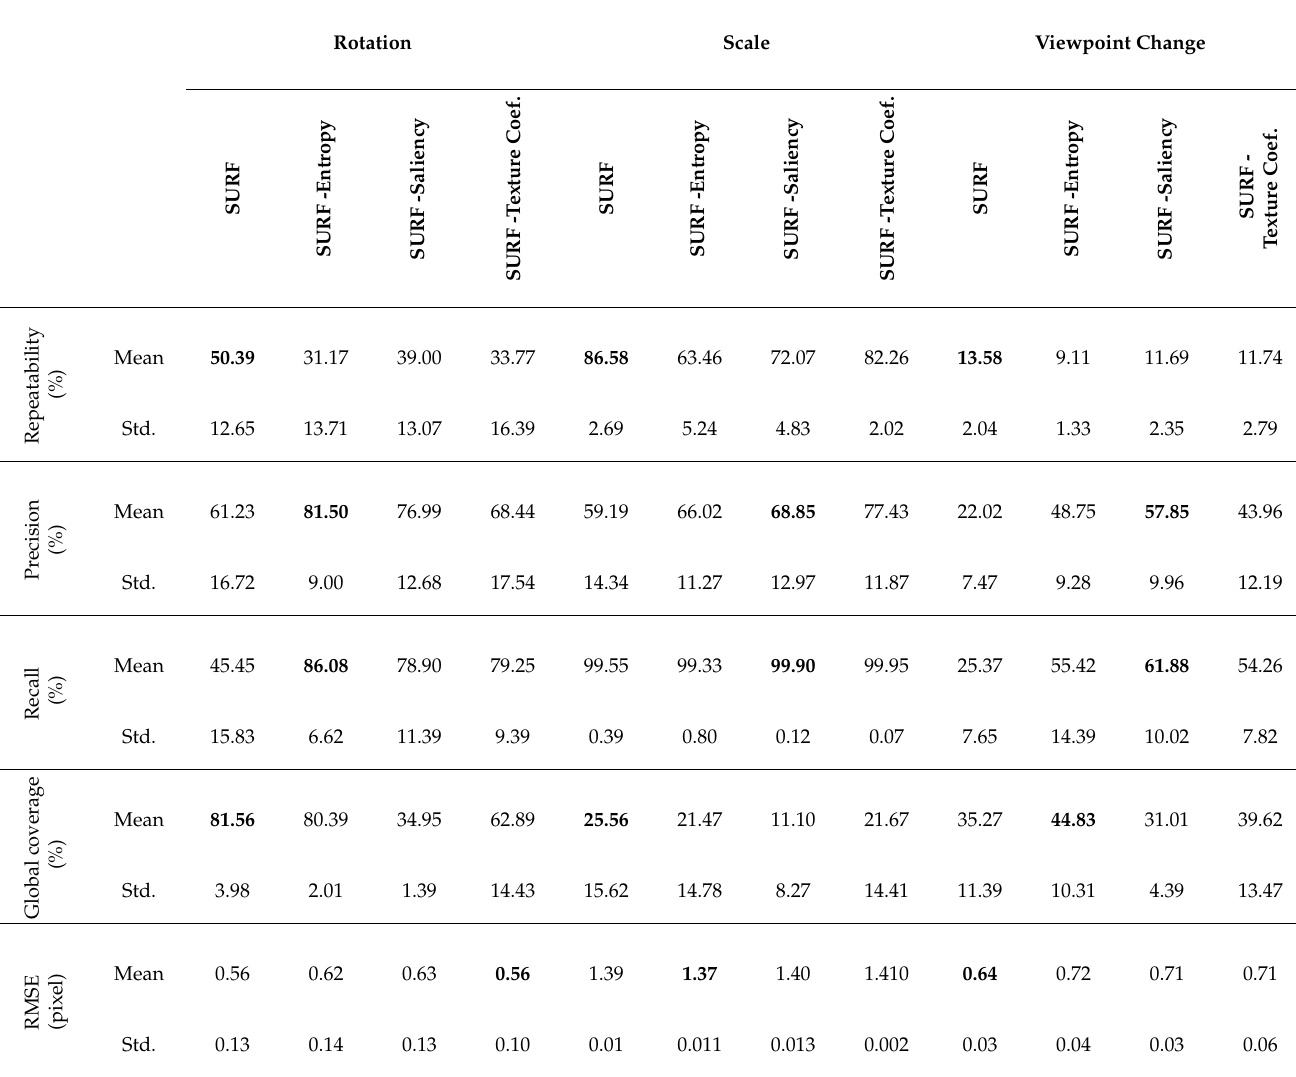
Table 4. The matching results of SURF detector in synthetic images. Rotation Scale Viewpoint